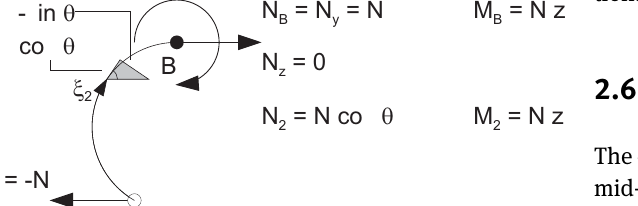
is a component of N obtained from the transformation rule